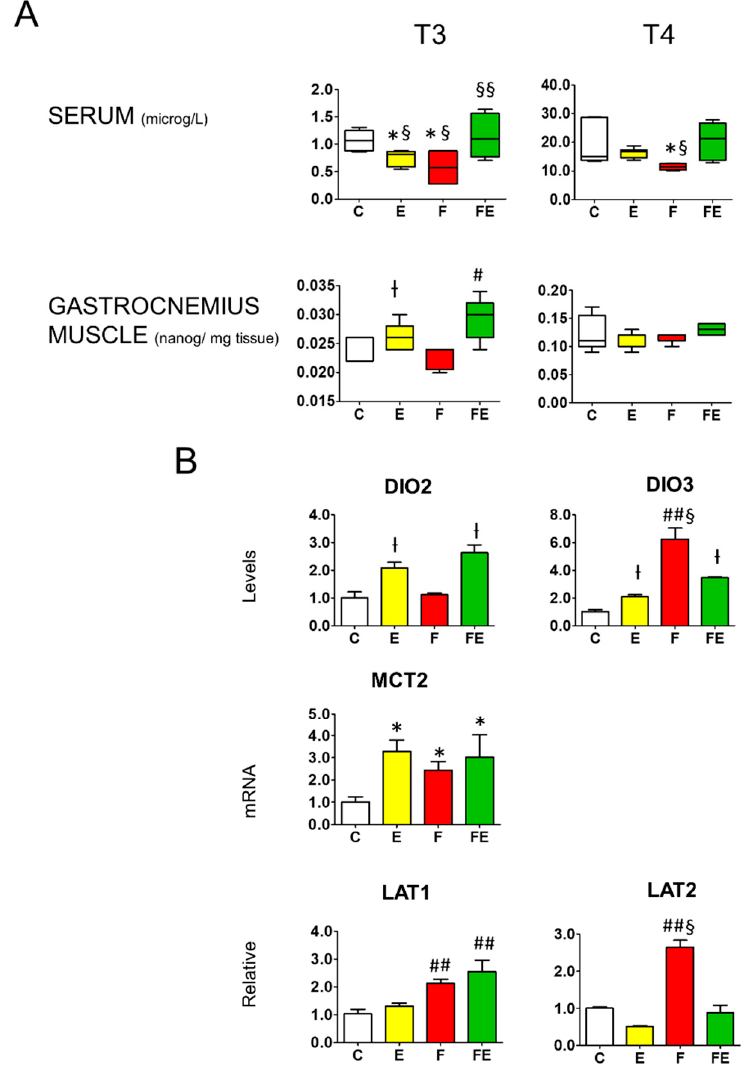
Figure 2. Comparison between serum and gastrocnemius muscle T3 and T4 levels and modulation of gastrocnemius muscle deiodinase 2 and deiodinase 3 mRNA levels, as well as those of BHB transporter MCT2, and amino acid transporters LAT1 and LAT2. ( A ): Mass Spectrometry analysis of serum and gastrocnemius muscle levels of T3 and T4. ( B ): Q-PCR analysis of deiodinase 2 and 3, MCT2, LAT1 and LAT2 mRNA levels in gastrocnemius muscle. ( A , B ): Analysis was carried out using control rats or rats subjected to exercise, fasting, or fasting with exercise ( N = 4, n = 3). * p < 0.05 vs. C, † p < 0.05 vs. C and F, # p < 0.05 vs. E, F, and C, ## p < 0.05 vs. E and C, § p < 0.05 vs. FE, §§ p < 0.05 vs. F and E. One way ANOVA was carried out followed by a Newman Keuls post-hoc test. Data are shown as means ± SEM. Abbreviations: DIO2: deiodinase 2, DIO3: deiodinase 3, N: biological replications, n: technical